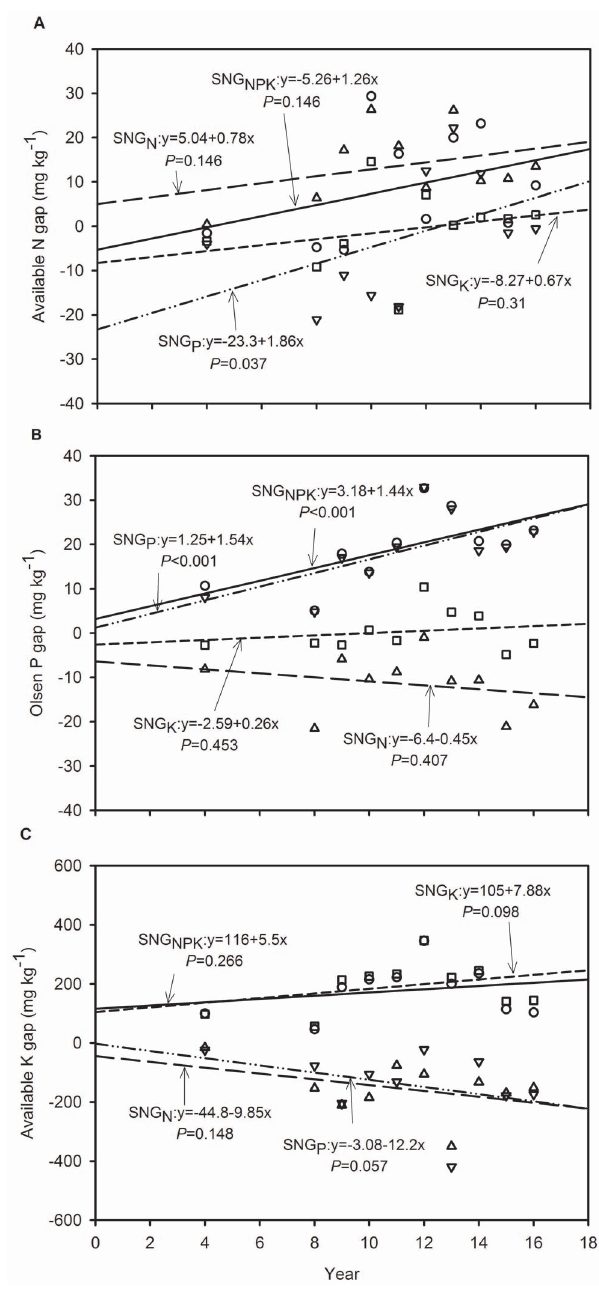
Figure 3. Soil available N (a), Olsen-P (b) and available K (c) gap variation by N (SNG N , soil available nutrient difference between NPK and PK plots, triangle up), P (SNG P , the difference between NPK and NK plots, triangle down), K (SNG K , the difference between NPK and NP plots, square) or NPK (SNG NPK , the difference between NPK and Control plots, circle) fertilizer omission from 1994 to 2006 during wheat season at Yucheng, Shandong Province of China.